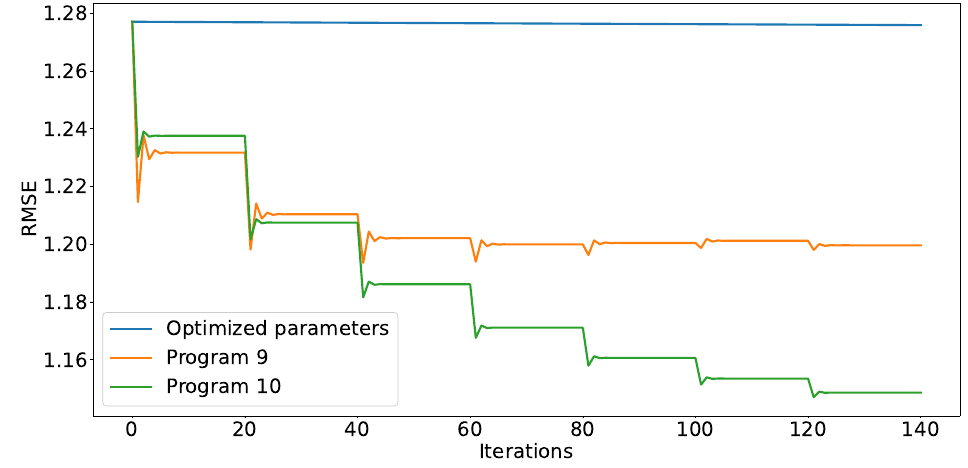
Figure 3. Convergence of the RMSE value using the same equations as in Figure 2 but only 20